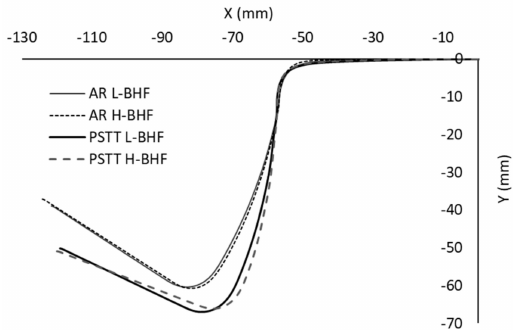
Figure 12. Experimental representation of the resultant channels after springback in the AR and PSTT materials under low blank holding forces (L-BHFs) and high blank holding forces